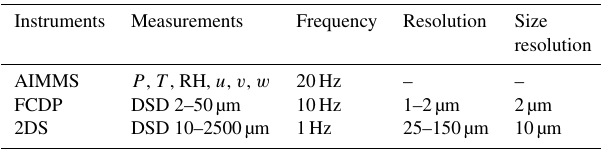
Table 1. In situ cloud instruments from ACE-ENA campaign used in this